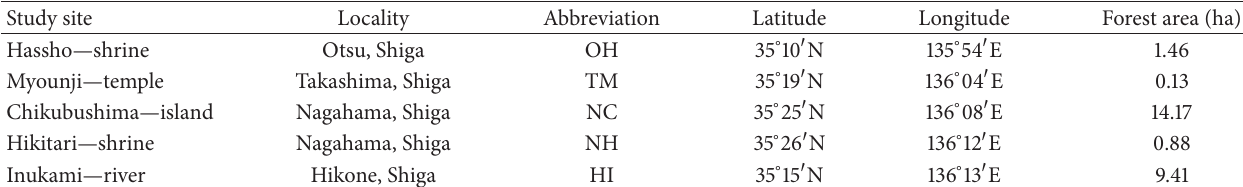
Table 1: Location and size of each M. thunbergii study